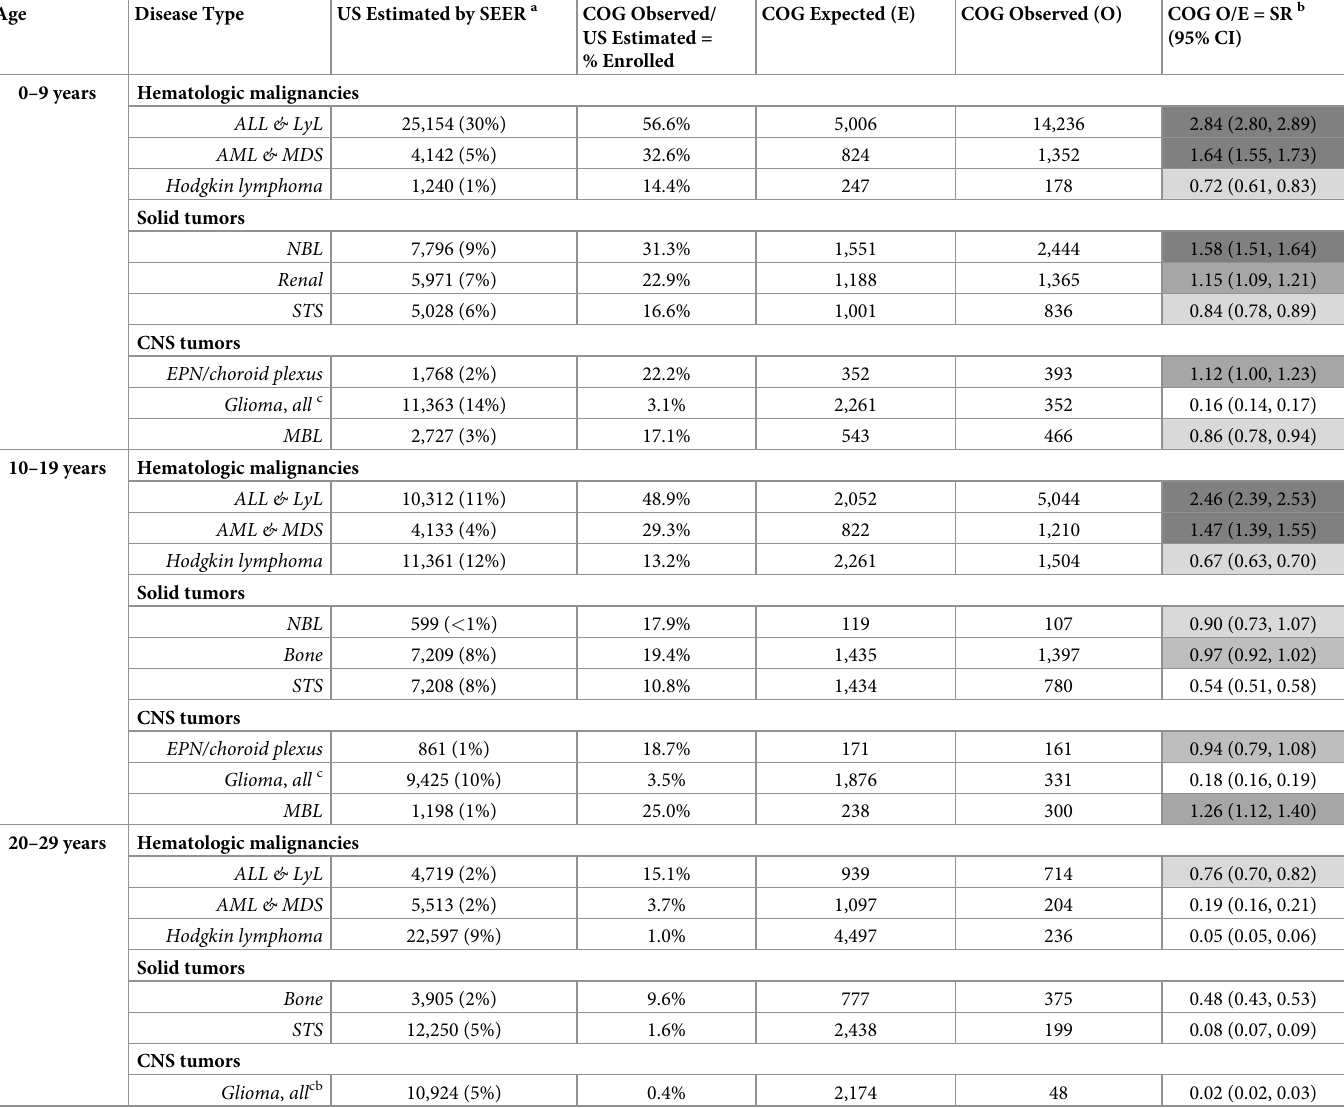
Table 3. COG enrollment by disease type (most prevalent in age group), stratified by age, 2004–2015. Age Disease